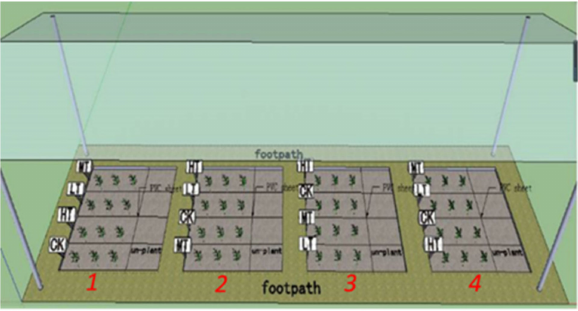
Figure 1. The layout of the study site. The plots numbers (1, 2, 3, and